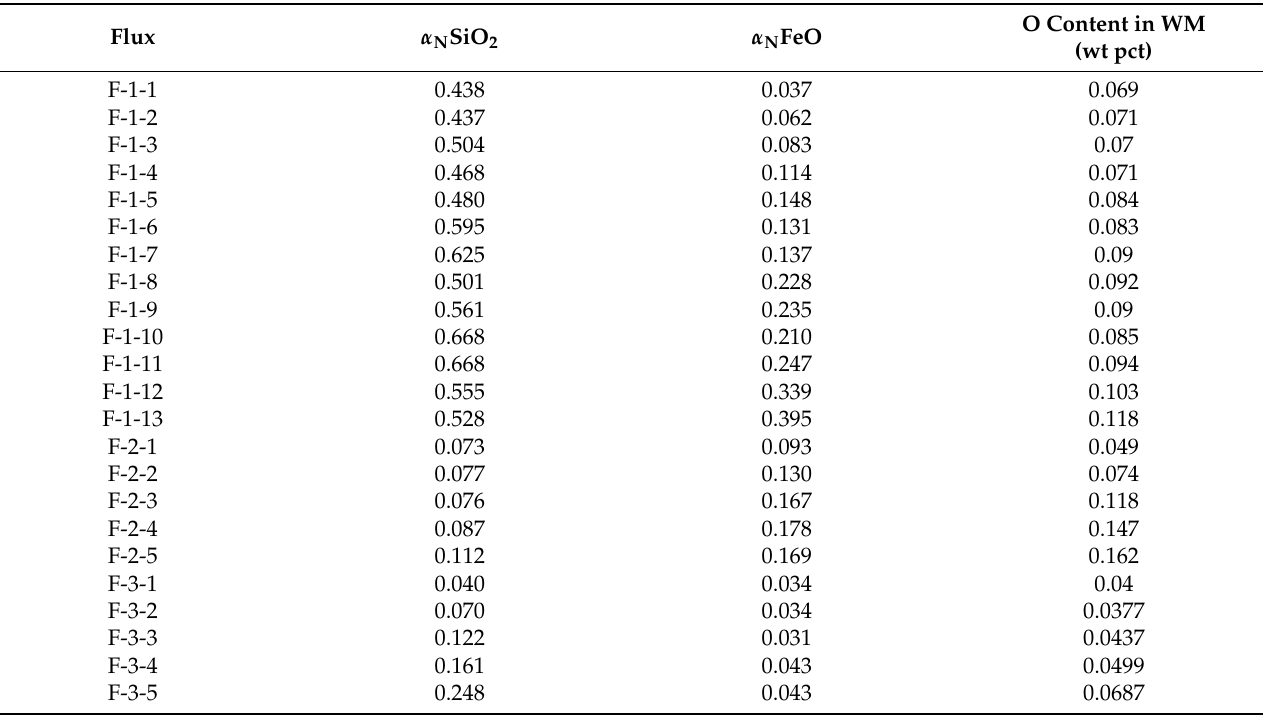
Table 4. SiO 2 and FeO activities in bulk slag.